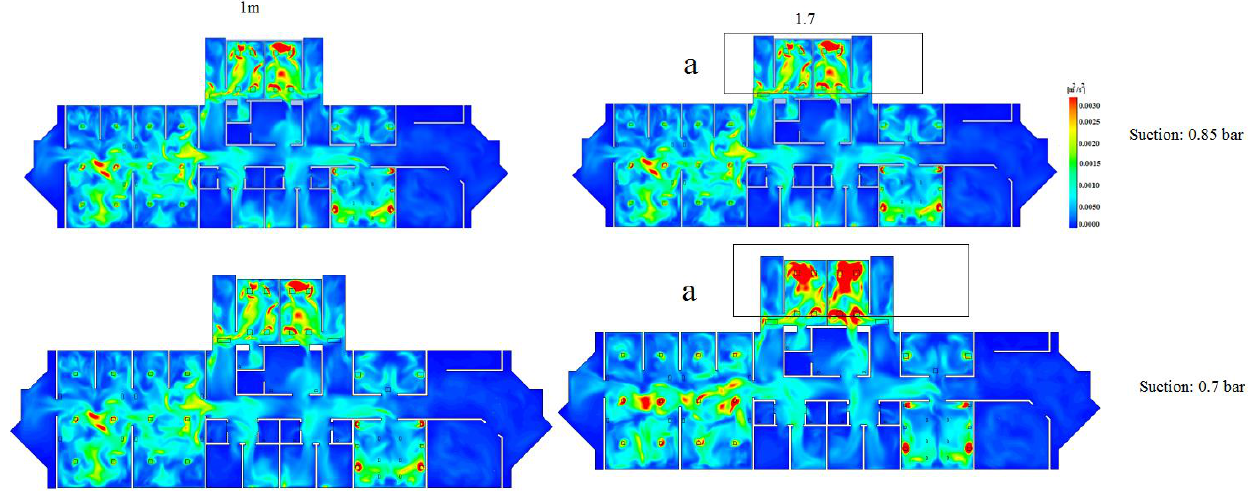
Figure 10. Turbulence kinetic energy profile for the 1 m and 1.7 m planes at two suction levels (0.85 and 0.7 bar).